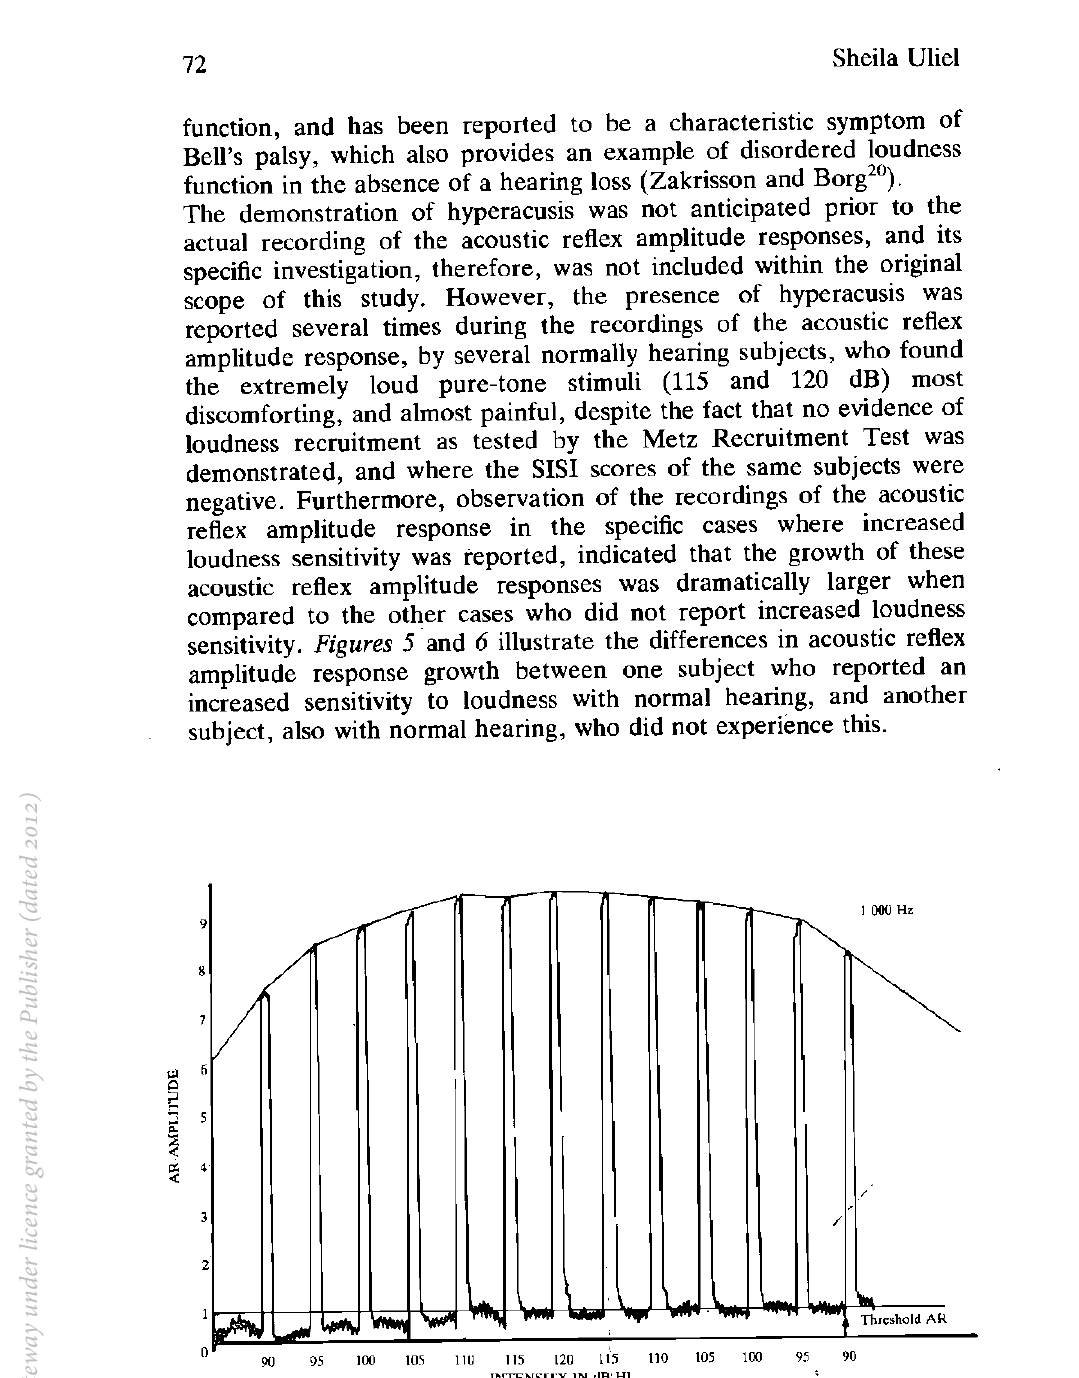
Figure 5. Example of acoustic reflex amplitude response growth in a case of normal hearing where hyperacusis was